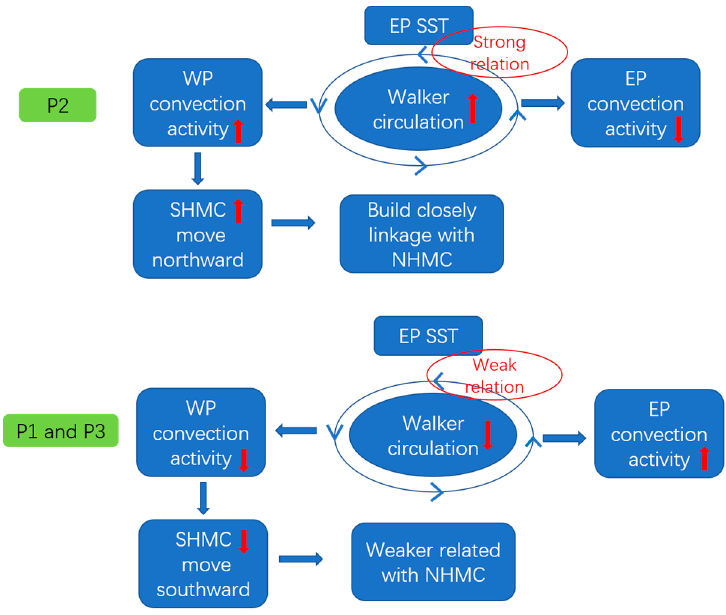
Figure 12. The schematic diagram of the possible mechanisms. The red arrow up indicates the system strengthens, the red arrow down indicates the system weakens.